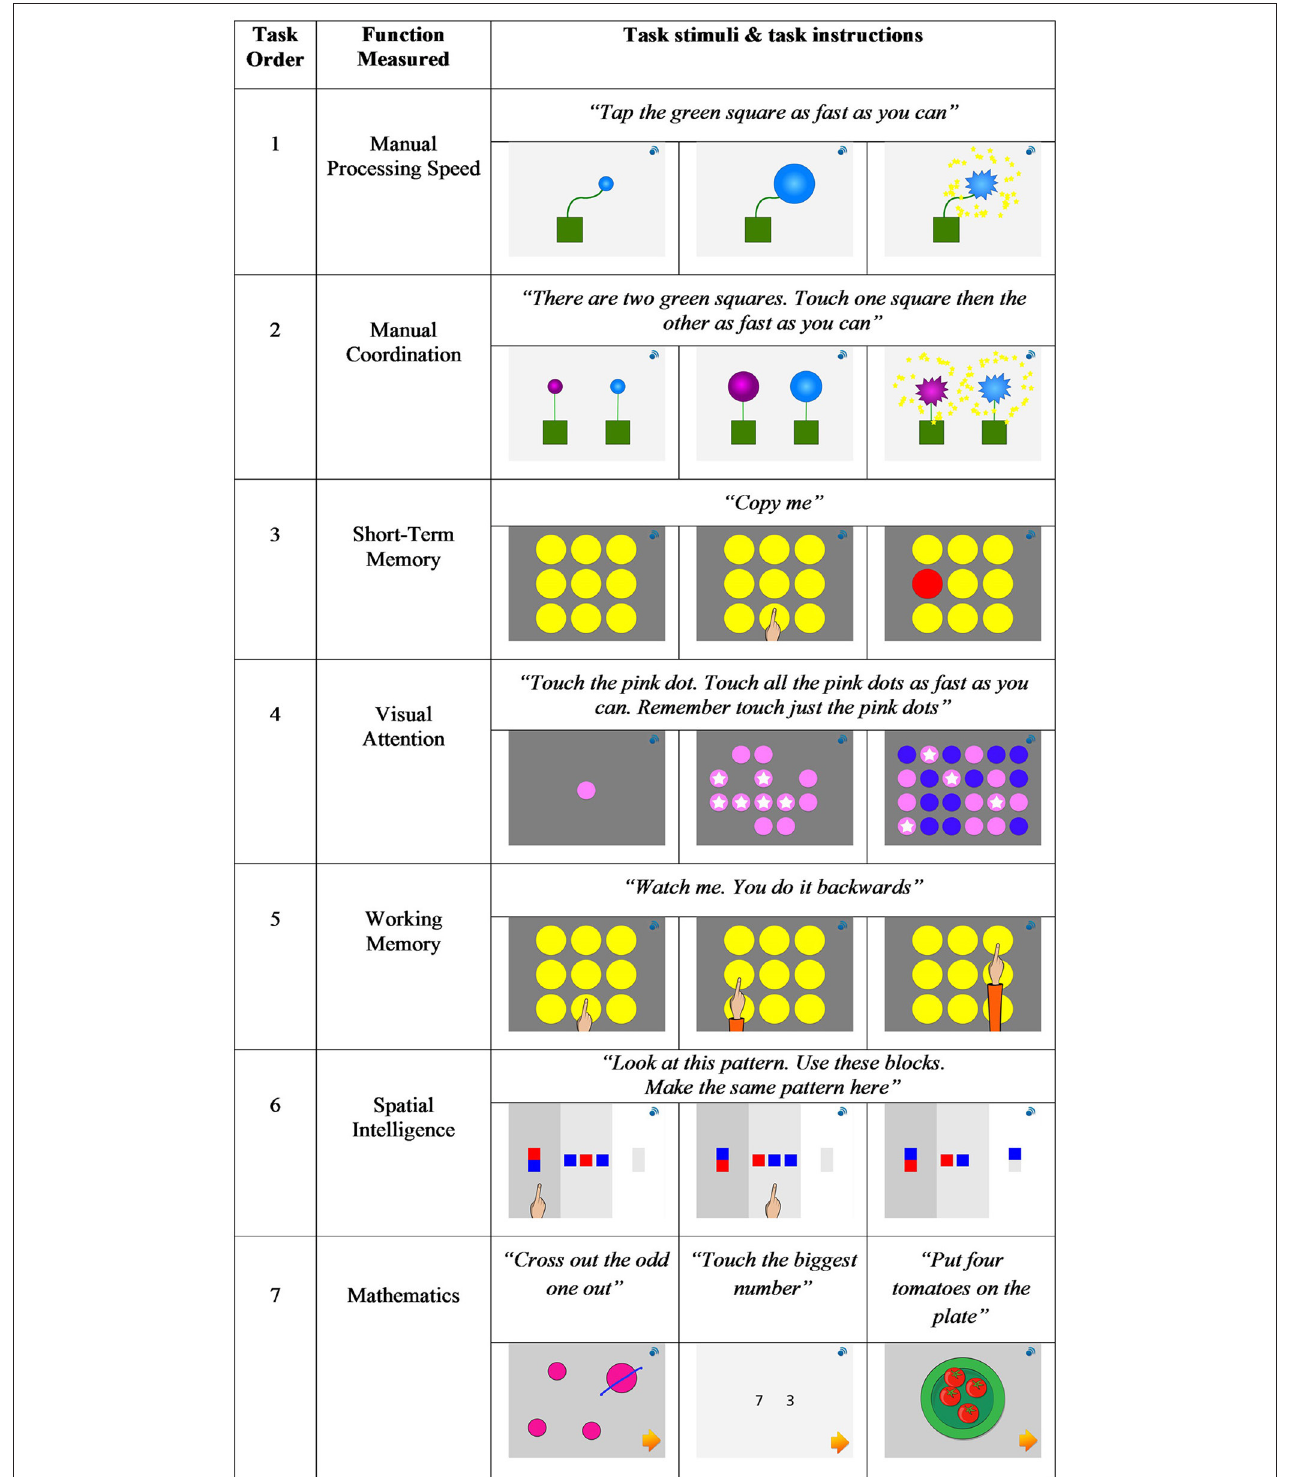
FIGURE 1 | Schematic illustration of tasks included in the new touch screen tablet-based assessment of cognitive and mathematical skills for primary school children.